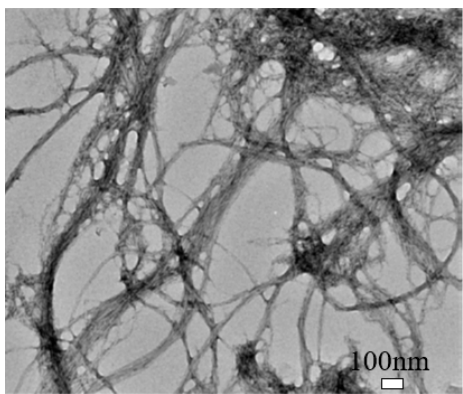
Figure 3. Transmission electron microscopy (TEM) image of cellulose nanofibril (CNF). Reproduced (adapted) from [38], with permission from American Chemical Society, 2013.